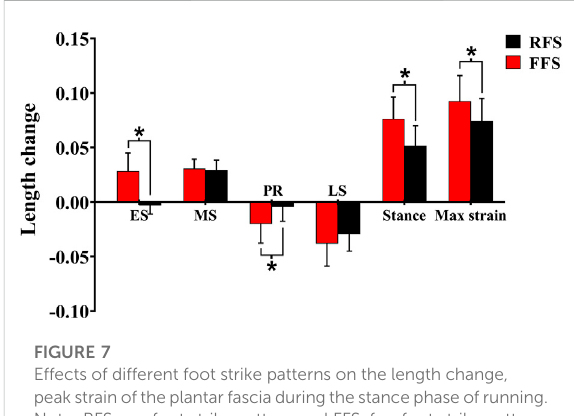
FIGURE 7 Effects of different foot strike patterns on the length change, peakstrainoftheplantarfasciaduringthestancephaseofrunning. Note: RFS, rearfoot strike pattern and FFS, forefoot strike pattern; ES, early stance phase; MS, mid-stance phase; PR, propulsion phase; LS, late stance phase; stance, entire stance phase; max strain, the maximum strain of the plantar fascia. * signi fi cant difference between FFS and RFS during running, p <